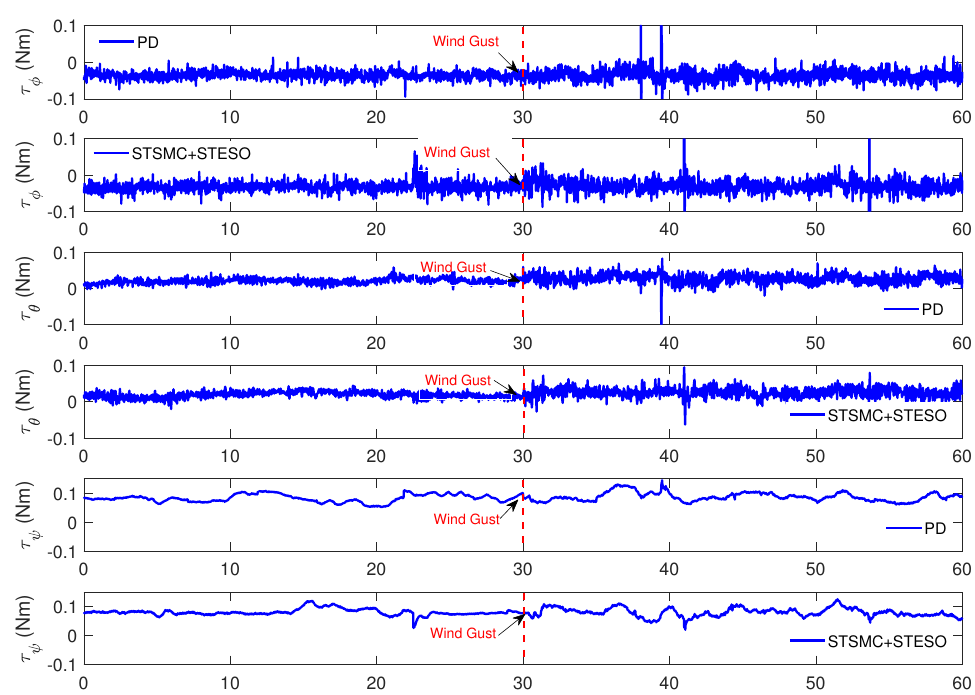
Figure 17. Control input during flight experiments in Case